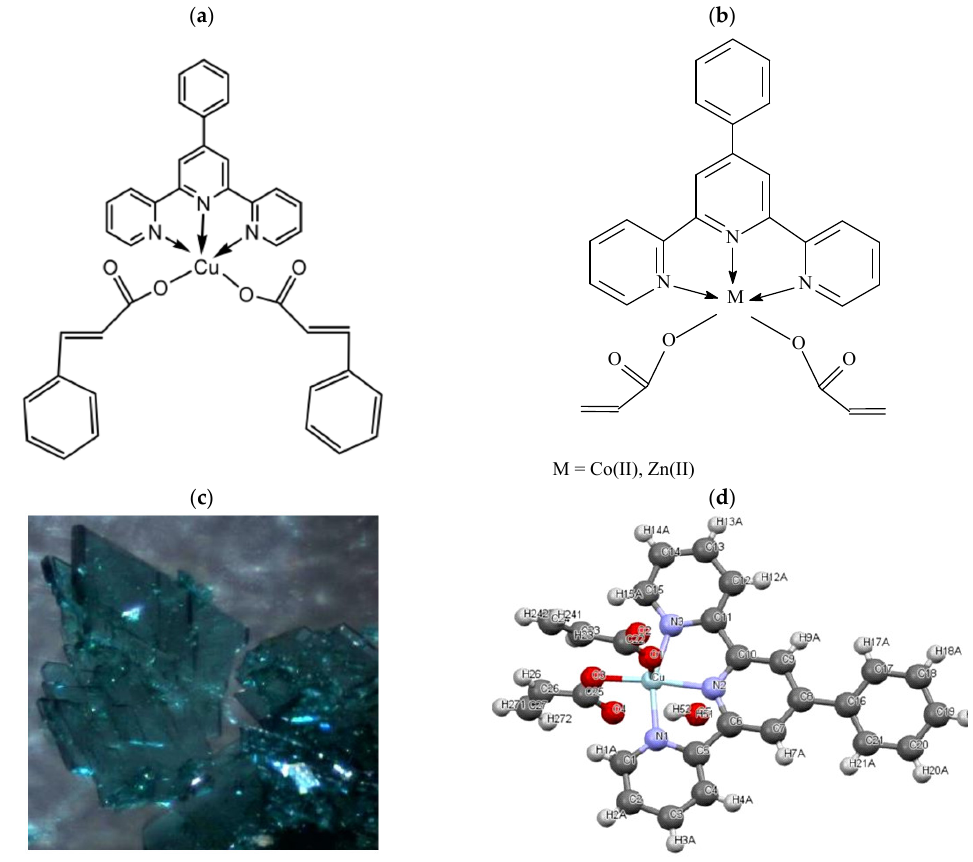
Figure 17. Schematic representation of synthesized MCMs with pendent 4-phenyl-2,2’:6’,2″-terpyridine ligand ( a )—CuCinnamatePhTpy, ( b )—ZnAcrylatePhTpy and CoAcrylatePhTpy, ( c )—appearance of crystals of the CuAcrylatePhTpy complex in the form of triclinic pyramids (prisms) and its molecular structure ( d ). Reprinted from [187] with permission from Elsevier. Ternary copolymers based on MCMs with phenylterpyridine ligands (MCMPhTpy), successfully obtained by radical copolymerization of MCMPhTpy with acrylic acid (AA) and acrylamide (AM), according to IR spectra, exhibit a developed network of hydrogen, coordination, and π–π bonds that play a decisive role in the manifestation of the self-healing properties of the obtained metallocopolymers (Figure 18) [180].